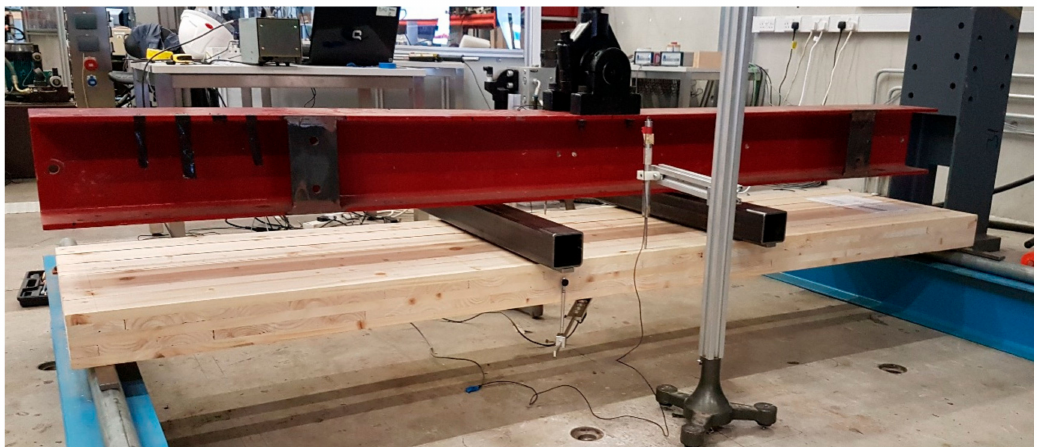
Figure 1. Four-point bending test set-up on a five-layer cross laminated timber (CLT) panel (B-5-20-7) over a span of 2400